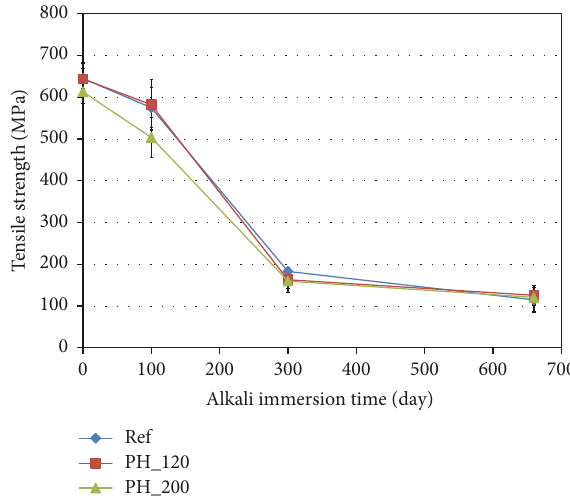
Figure 10: Tensile strength reduction according to alkali immersion